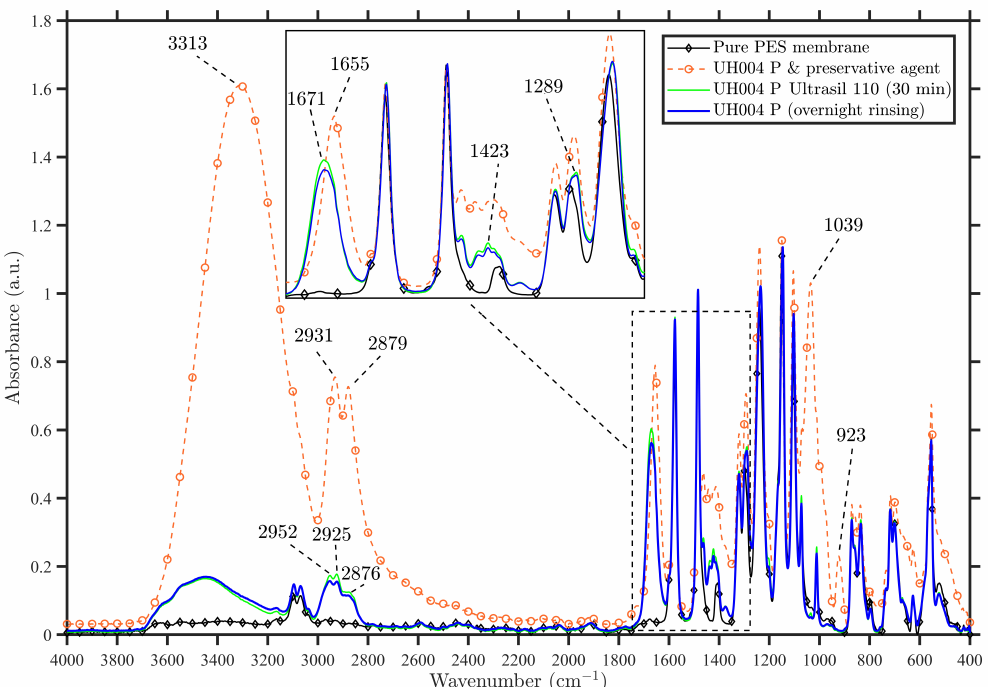
Figure 3. The effect of overnight rinsing with deionized (DI) water and 30 min precleaning with Ultrasil 110 cleaning agent on the ATR-FTIR spectra of the UH004 P membrane in the region of 4000–400 cm − 1